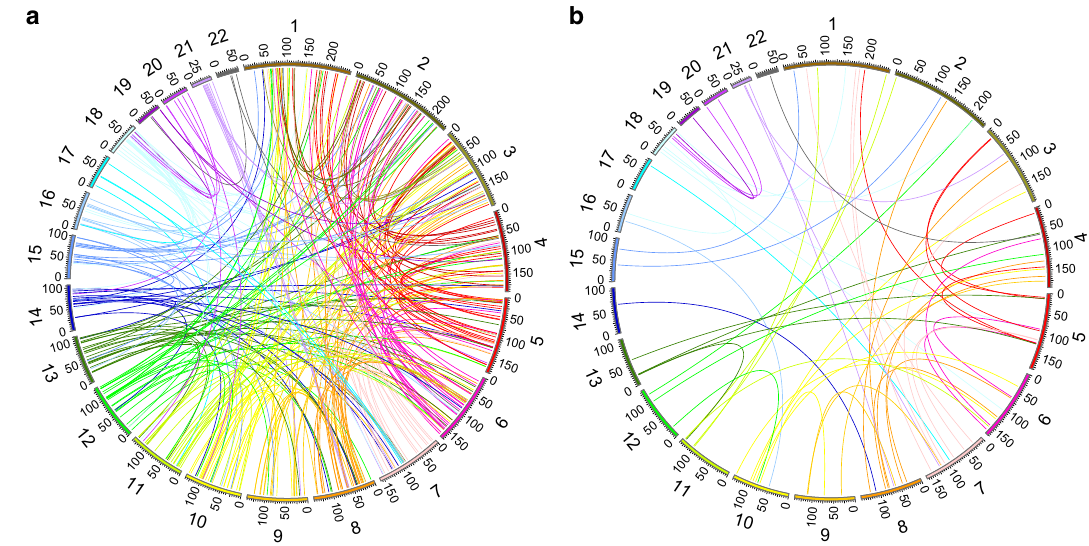
Fig. 6 Genome-wide inter-chromosomal contact changes in 22q11.2del versus control cell lines. a Circos plot of the inter-chromosomal contacts exhibiting differential interaction in 22q11.2del ( n = 5) versus control ( n = 6) cell lines at signi fi cance level of Student ’ s t test p value = 0.0001. b Circos plot of the inter-chromosomal contacts exhibiting differential interaction in 22q11.2del ( n = 5) versus control ( n = 6) cell lines at signi fi cance level of Student ’ s t test p value = 0.0001 and showing only the top 5% strongest inter-chromosomal contacts. The circle displays all autosome-sized scaffolds and each line represents an inter-chromosomal contact change in a ,